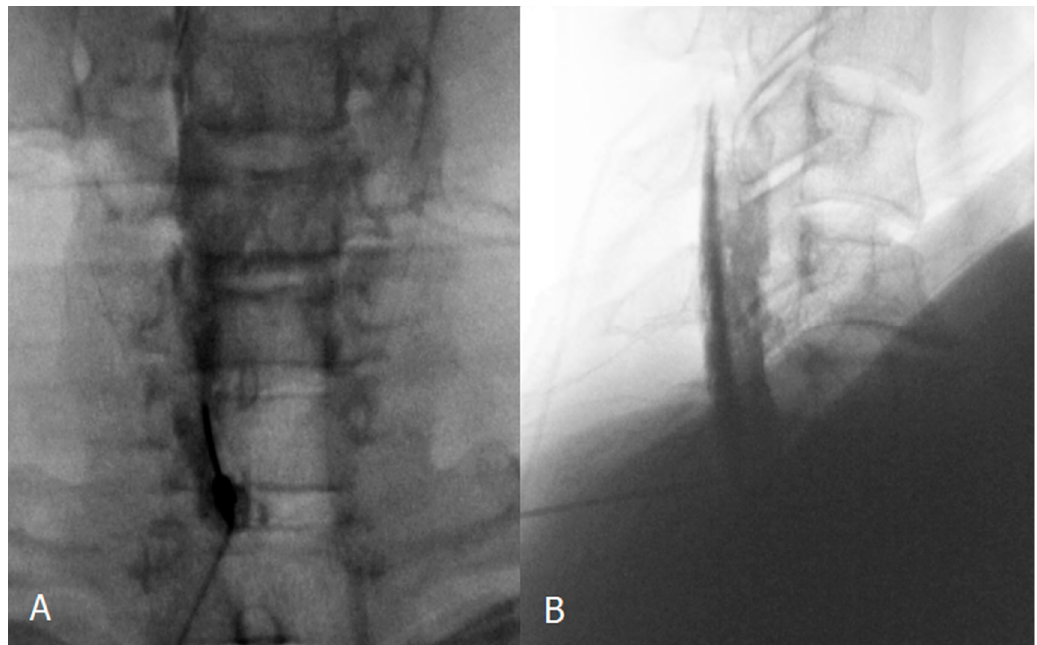
Figure 5. Confirmatory contrast medium spread of cervical interlaminar epidural injection. Anteroposterior ( A ) and lateral ( B ) cervical epidurogram showing left paramedian approach at C6-7 level. Contrast medium spreads predominantly longitudinally and bilaterally, but it did not reach to the ventral epidural space.